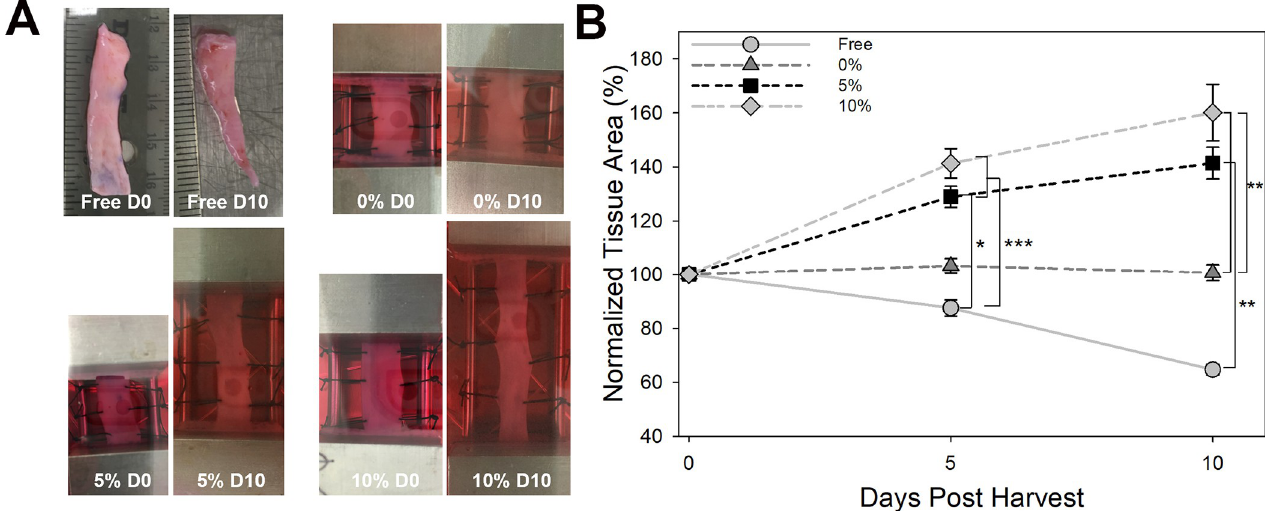
Fig 2. Ex vivo expansion of periosteal tissue is not linear with total applied strain. A) Photographs of periosteum at day 0 and after 10 days of culture. Note the decrease in periosteal strip width in the 10% group. B) Quantification of periosteal area normalized to day 0.